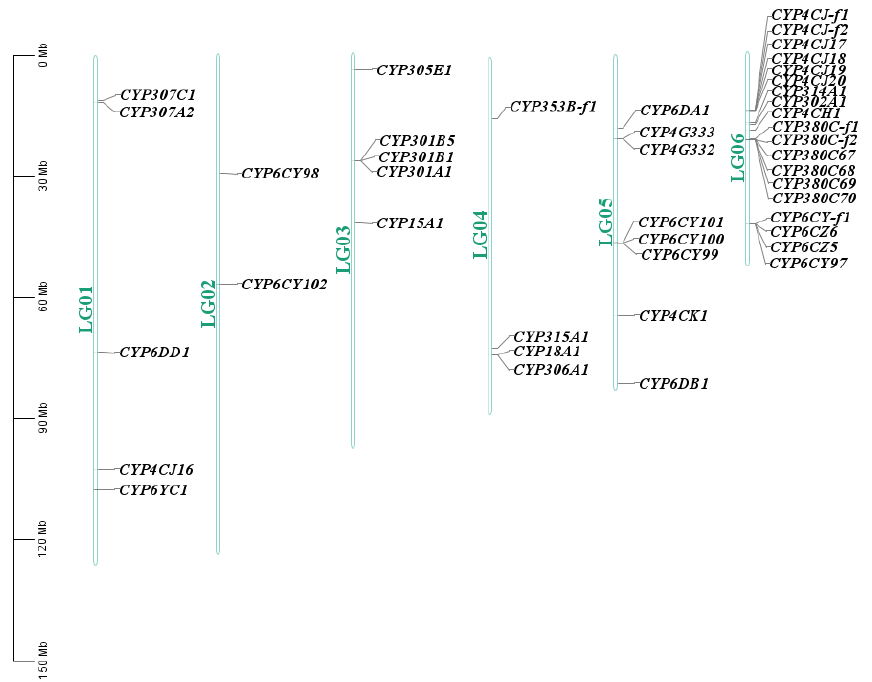
Figure 3. The chromosomal distribution of predicted P450 genes in the genome of Pseudoregma bambucicola .